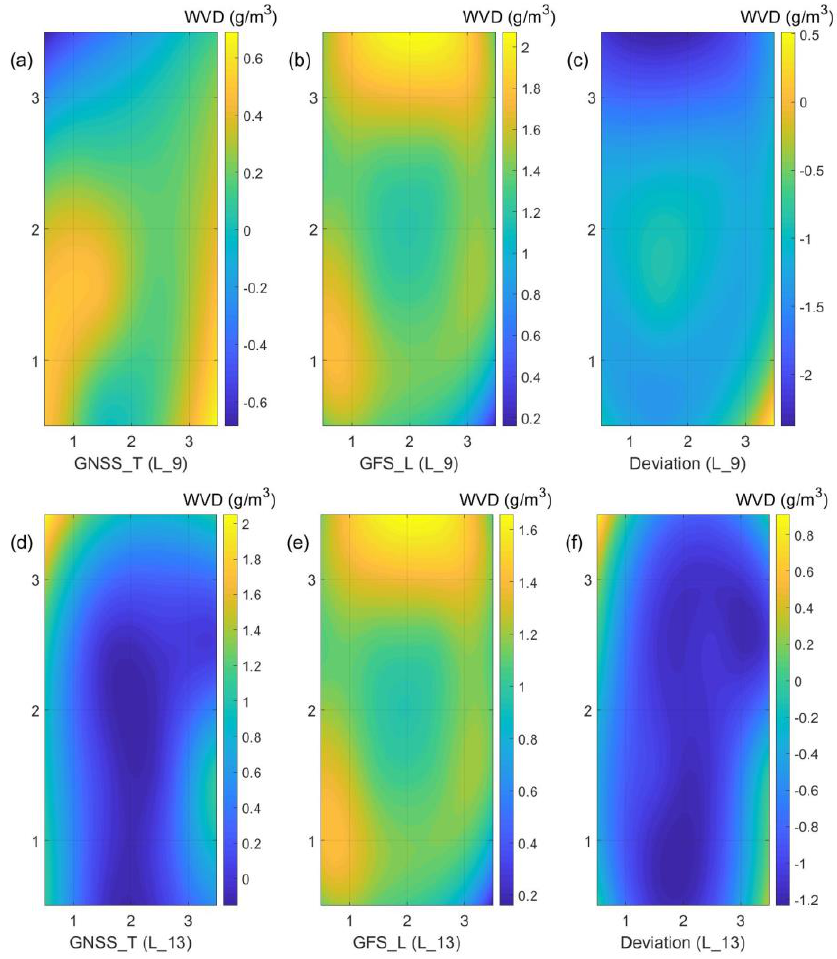
Figure 10. ( a ) GNSS_T of the ninth layer; ( b ) GFS_L of the ninth layer; ( c ) Deviation between GNSS_T and GFS_L of the ninth layer; ( d ) GNSS_T of the thirteenth layer; ( e ) GFS_L of the thirteenth layer; ( f ) Deviation between GNSS_T and GFS_L of the thirteenth layer.